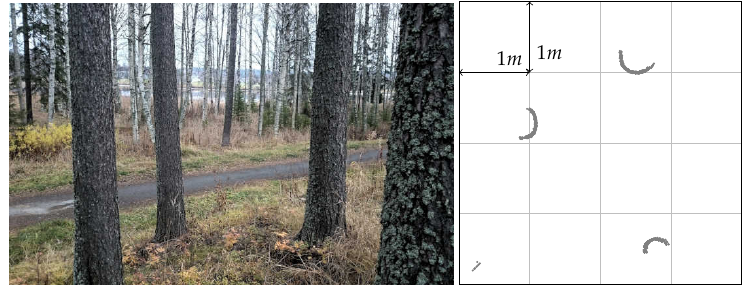
Figure 2. Raw measurements (right plot) from a non-calibrated triangulation lidar surrounded by trees in a forest (the ones in the left picture).